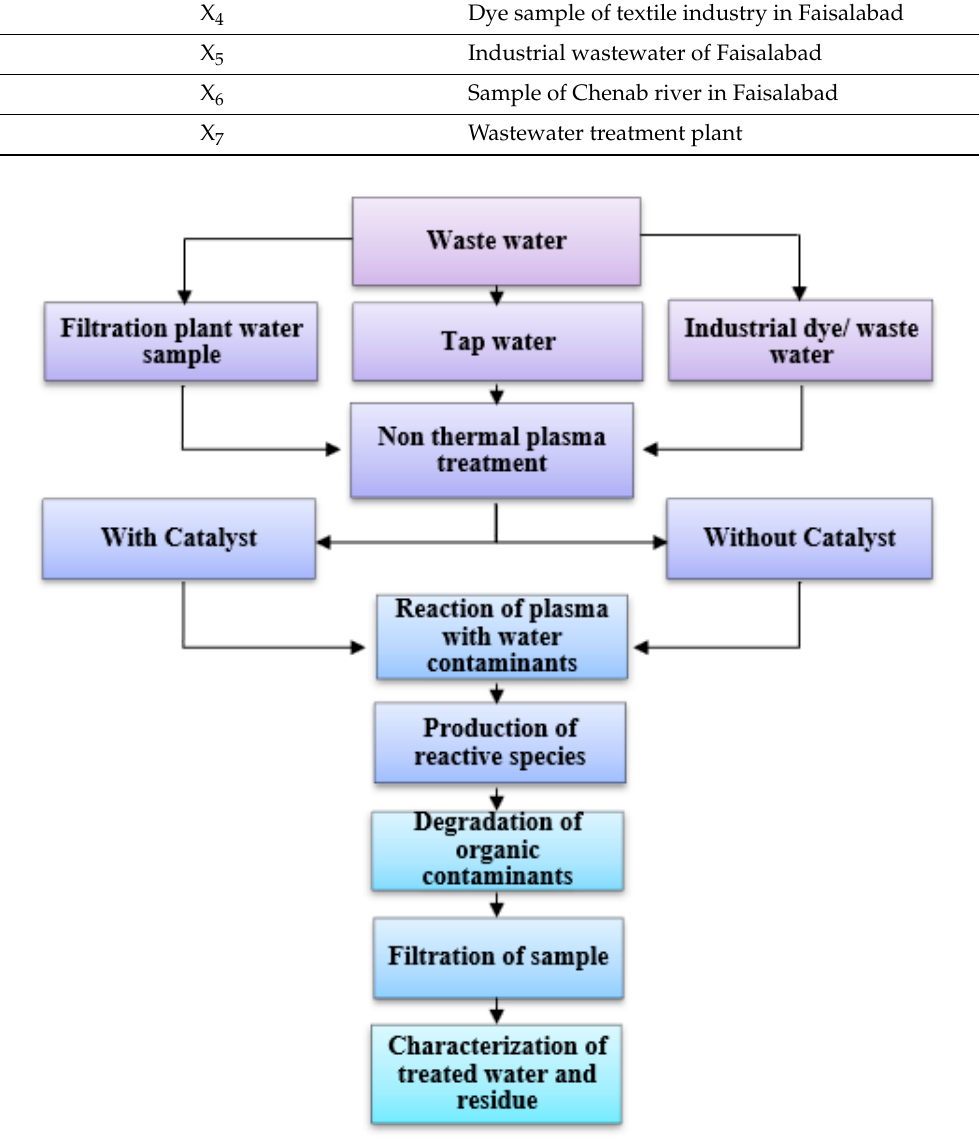
Figure 1. Flowchart of the plasma-assisted treatment of water samples with TiO 2 .